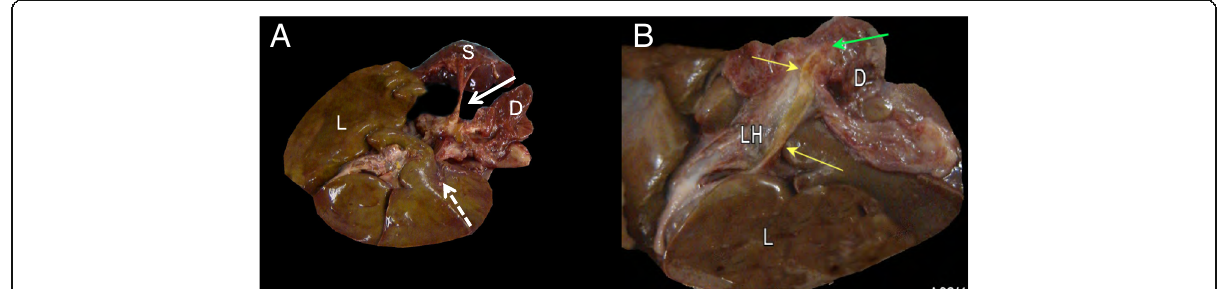
Fig. 1 a No pancreatic tissue could be identified on the orthotopic location along the splenic vessels ( white arrow ) nor gall bladder ( dashed arrow ). b View at het choledocus ( yellow arrows ). No ductus cysticus nor gall bladder. The choledocus ends in the duodenum (D) via Vater ’ s Ampulla ( green arrow ). Wirsung duct an ventral pancreas are absent. L: Liver, LH: liver hilum, S:spleen